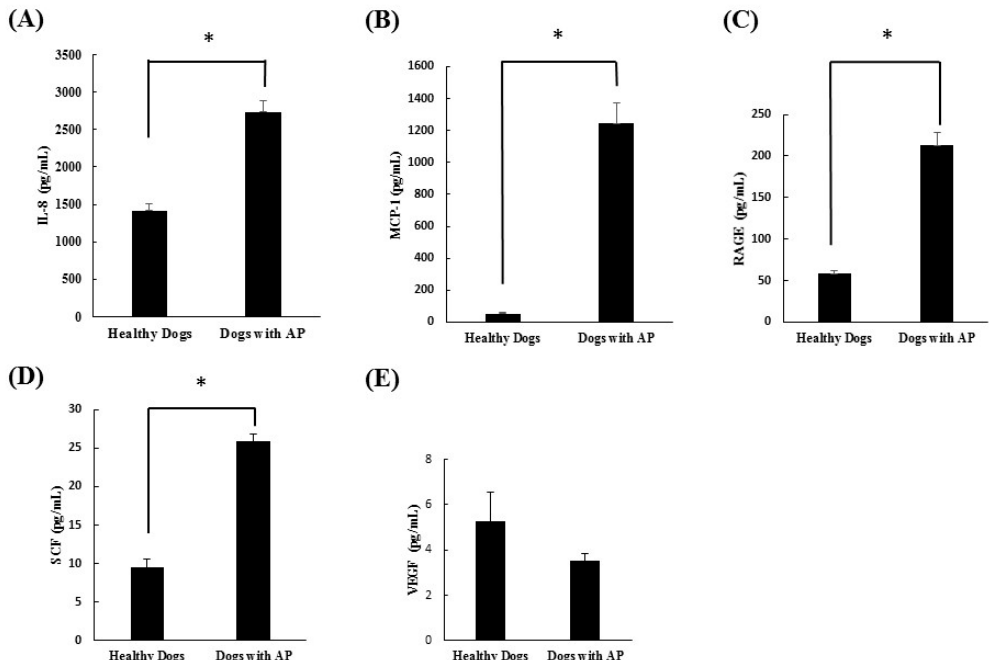
Figure 1. Comparison of ( A ) IL-8, ( B ) MCP-1, ( C ) RAGE, ( D ) SCF, and ( E ) VEGF in dogs with suspected acute pancreatitis (n = 3) and healthy dogs (n = 3) by canine cytokine antibody array. * p < 0.05. AP: suspected acute pancreatitis